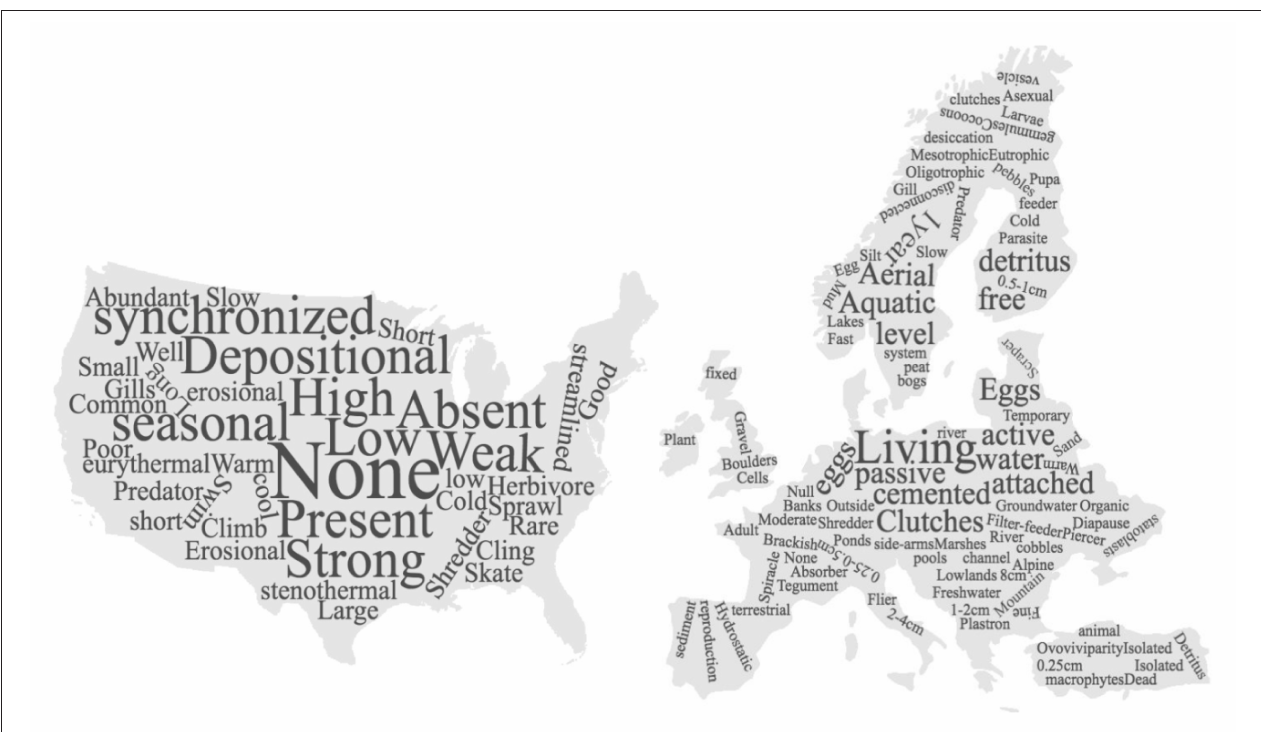
FIGURE 1 | Diagram displaying the different trait modalities used in the North American and the European trait databases for aquatic